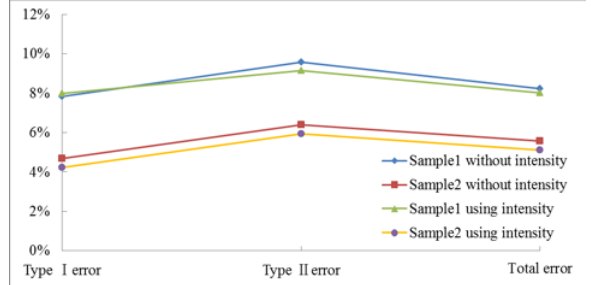
Figure 3. Performance comparison results